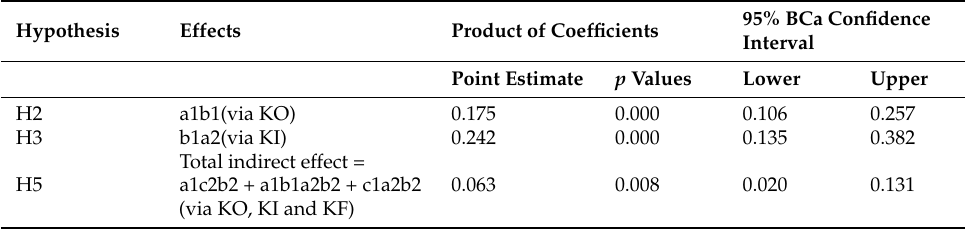
Figure 1. Structural model: A multiple mediation model. Note: *** indicates a significance level of p < 0.001; c1 ′ , c2 ′ and c3 ′ denote direct effect whereas c3 represents total effect. Table 8. Summary of mediating effects tests.